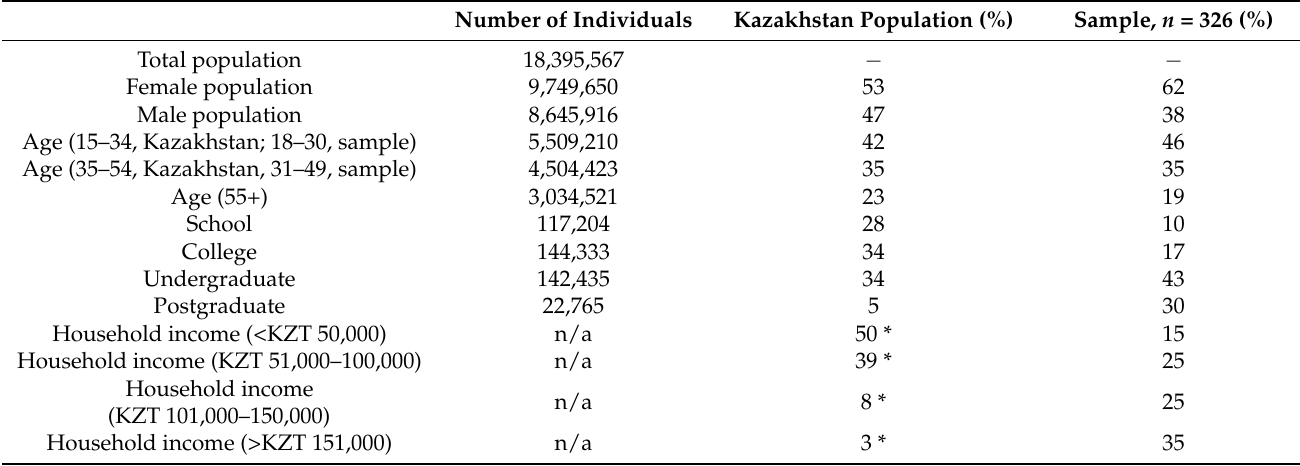
Table 3. Socioeconomic characteristics of Kazakhstan population (2019), percentage of Kazakhstan population versus percentage of the